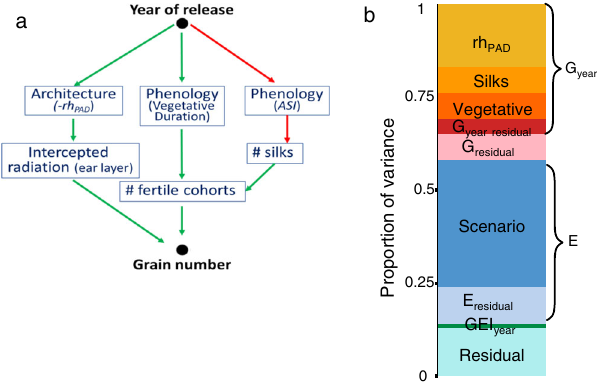
Fig. 3 The year of release affected grain number via phenology and plant architecture. a Bayesian network analysis of conditional dependencies between year of release, grain number, and phenotypic traits. Presented arrows are consensus in all environmental scenarios, green and red: positive (resp negative) relationships. rh PAD , distance, from top of the canopy, of the layer with 50% of total leaf area, in % of canopy height. layer hosting ears, normalized by incident light. # fertile cohorts, number of